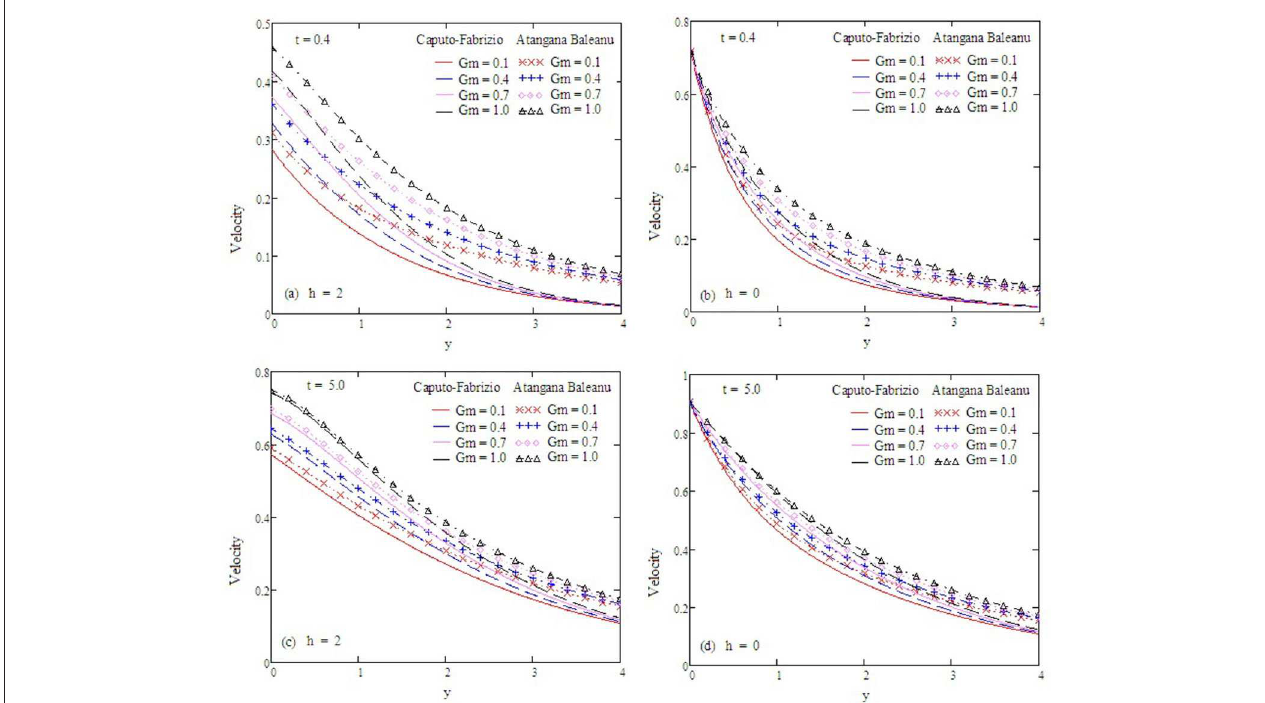
FIGURE 14 | Velocity profiles with altered values of G m and other parameters are ω